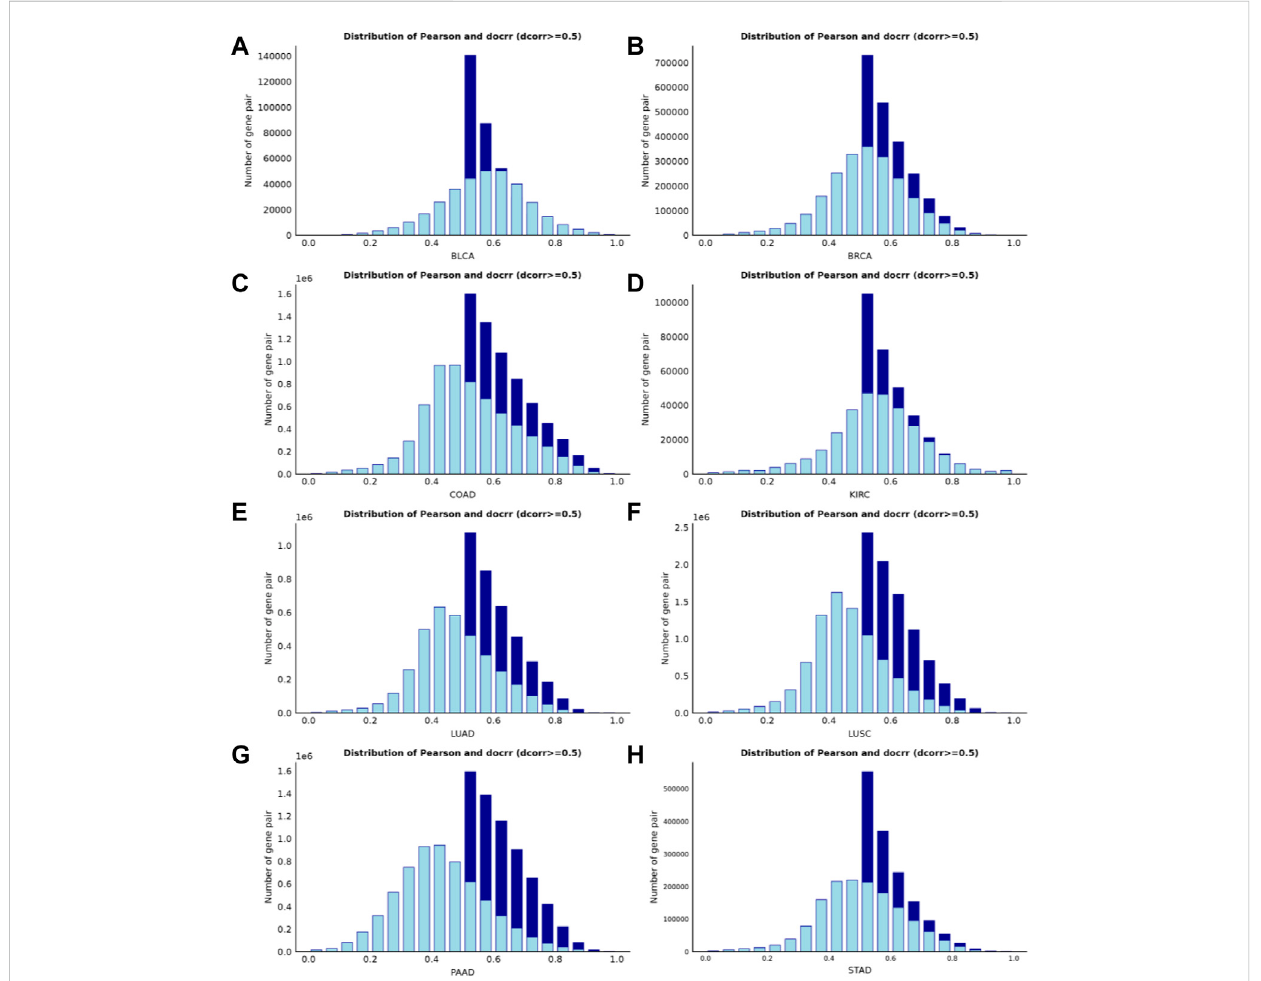
FIGURE 2 Histogram of correlation coef fi cients for interactions with high distance correlation scores ( > 0.5). The bright blue borders in each panel represents thePearsoncorrelations,andthedarkbluebordersrepresentsthedistancecorrelations.WhenusingthecriterionthatthePearsoncorrelationcoef fi cient must be greater than 0.5, more than 50% of the complex correlated data information on four of the datasets (Figures 2E – H) would be